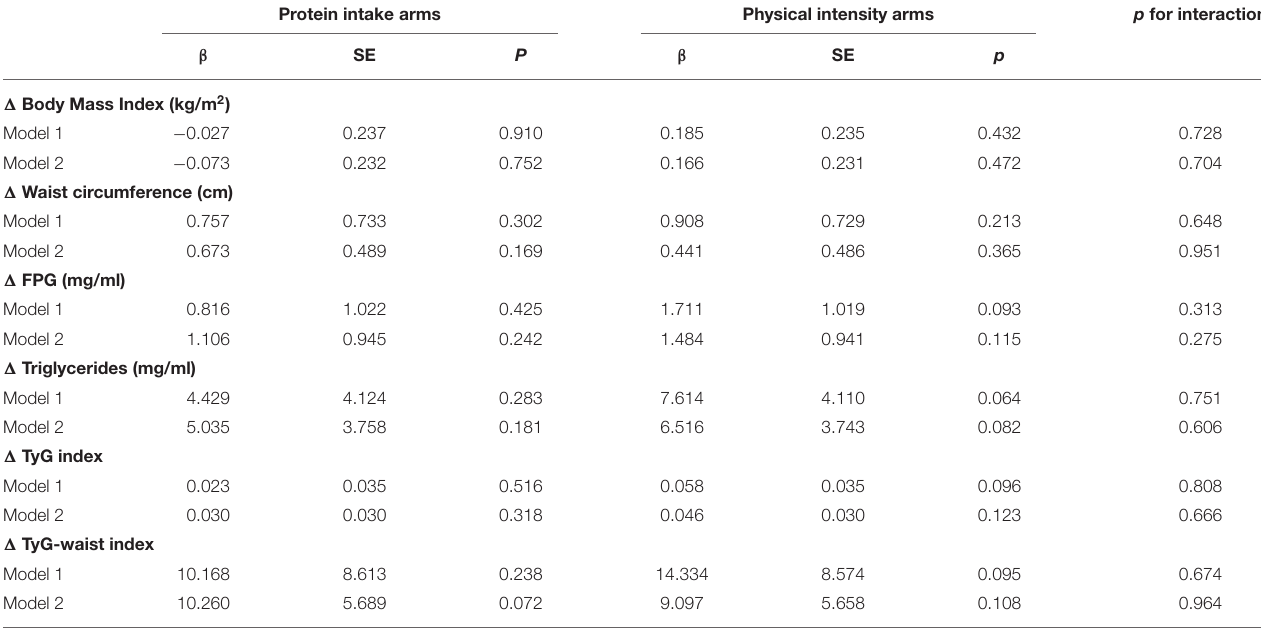
TABLE 3 | Regression models concerning the effect of intervention arms (diet and PA groups) on the variation of anthropometrical and biochemical markers as dependent variables after 36 months of intervention. Protein intake arms Physical intensity arms p for